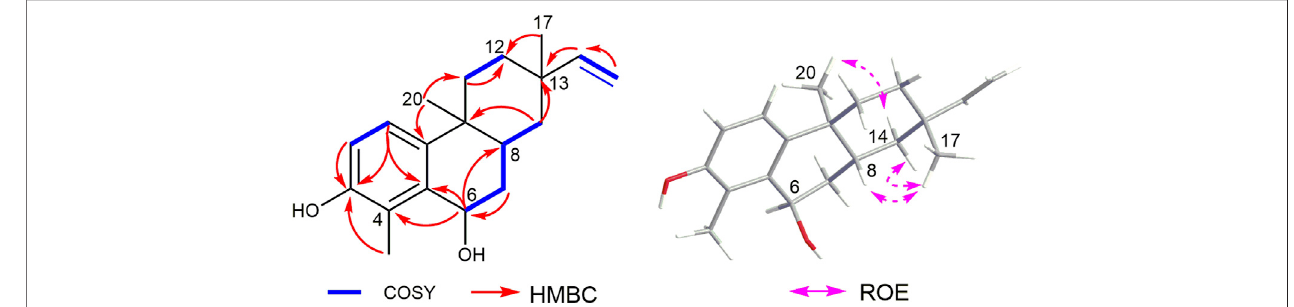
FIGURE 2 | Key 1 H – 1 H COSY, HMBC, and ROESY correlations of compound 1 .